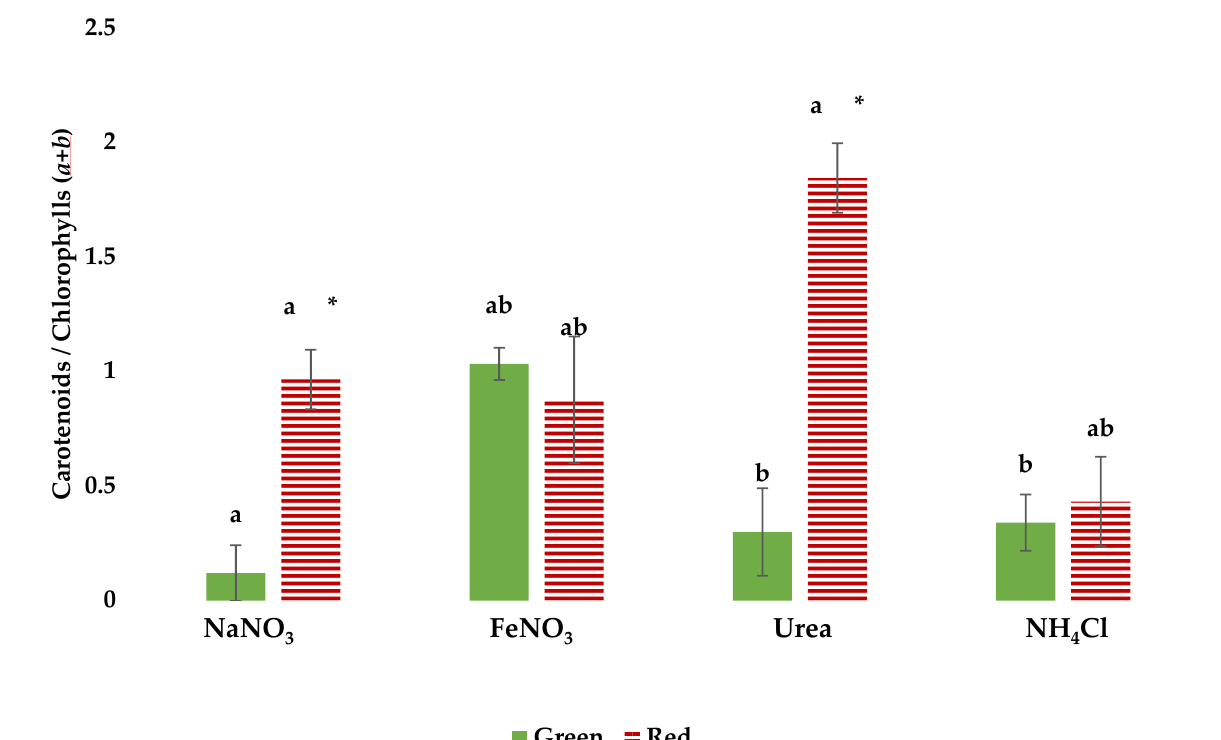
Figure 3. The letters indicate significant differences in the ratios between different nitrogen treatments during either the green or red growth phases ( p < 0.05), while the differences between the green and the red phase in each treatment are denoted by * ( p < 0.05).